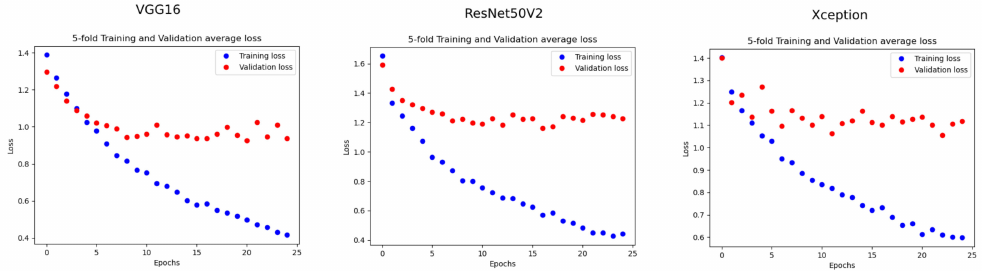
Figure 7. Five-fold cross-validation average loss over 40 epochs.